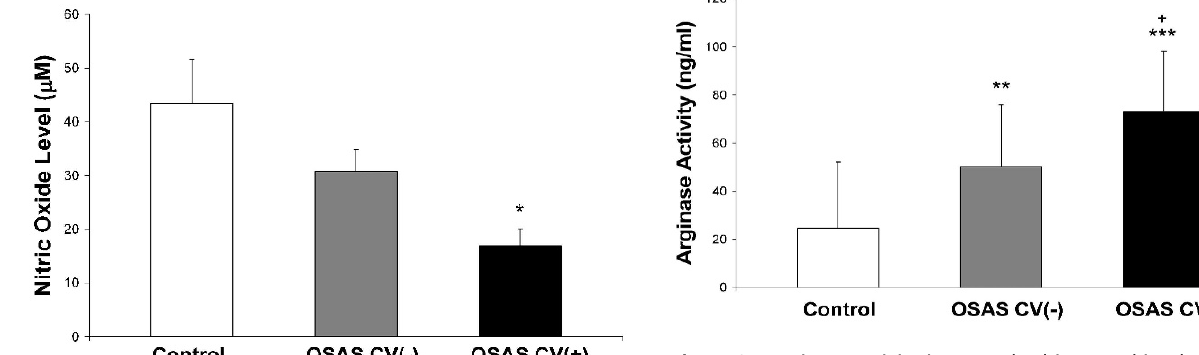
Figure 2 - Arginase activity in control subjects and in obstructive sleep apnea patients without (obstructive sleep apnea syndrome cardiovascular (-)) and with cardiovascular diseases (obstructive sleep apnea syndrome cardiovascular ( + )) ** p , 0.01 and *** p , 0.001 compared with the control group; + p , 0.05 com- pared with the obstructive sleep apnea syndrome cardiovascular (-)